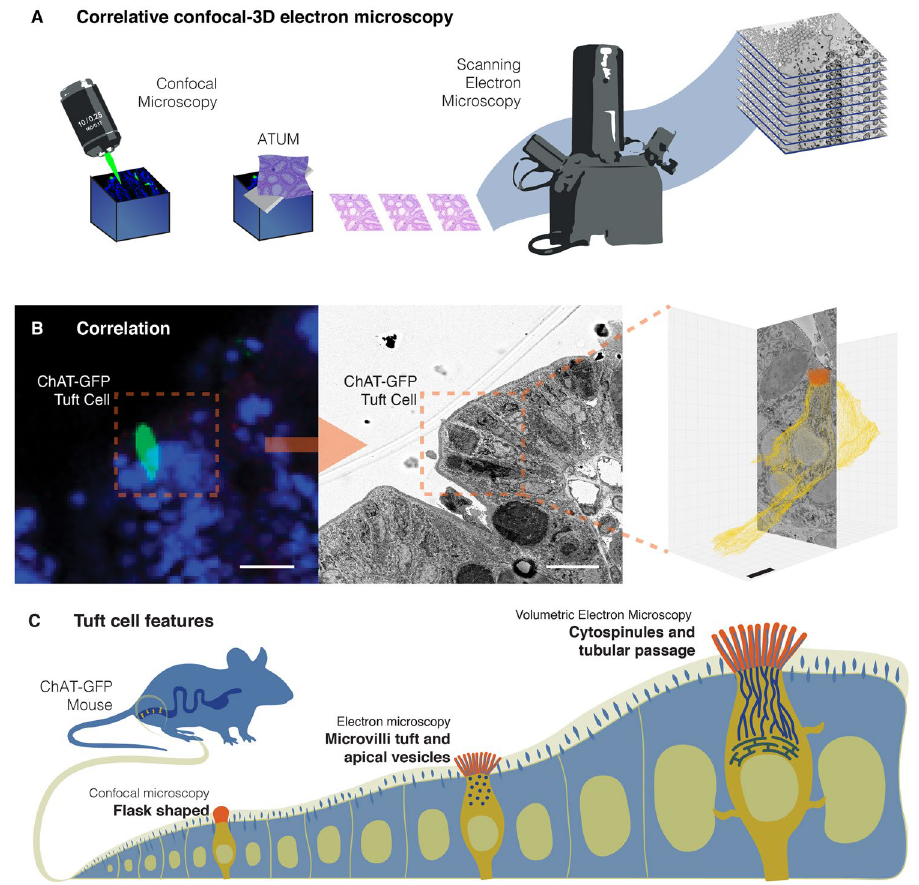
Figure 1. Identifying tuft cells for volumetric electron microscopy. ( A ) Overview of correlative method to identify a specific cell by fluorescence, then performing targeted scanning electron microscopy to uncover the ultrastructure of the desired cell in the third dimension. ( B) A tuft cell in the colonic epithelium of ChAT- GFP transgenic mice is identified by fluorescence (B-left) and ATUM SEM (B-center), then volume rendered from serial images using data visualization software (B-right). ( C ) Volumetric EM analysis of tuft cells revealed cytospinules and a gut-to-endoplasmic reticulum passage. Bars in B-left and middle = 10 µ m, bar in B-right = 1 µ